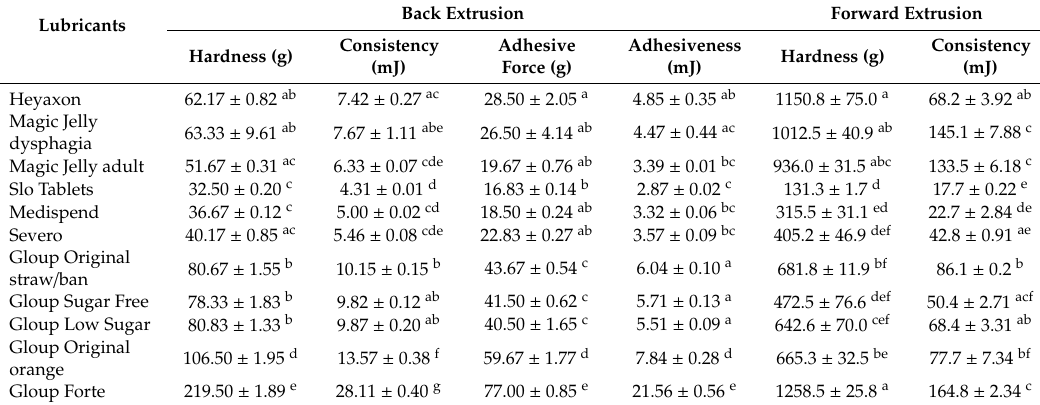
Table 6. Extrusion test results for the medication lubricants at room (24 ◦ C). Mean values followed by unlike superscript letters (a–g) within a column are statistically di ff erent ( p < 0.05). The data are mean ± se for three